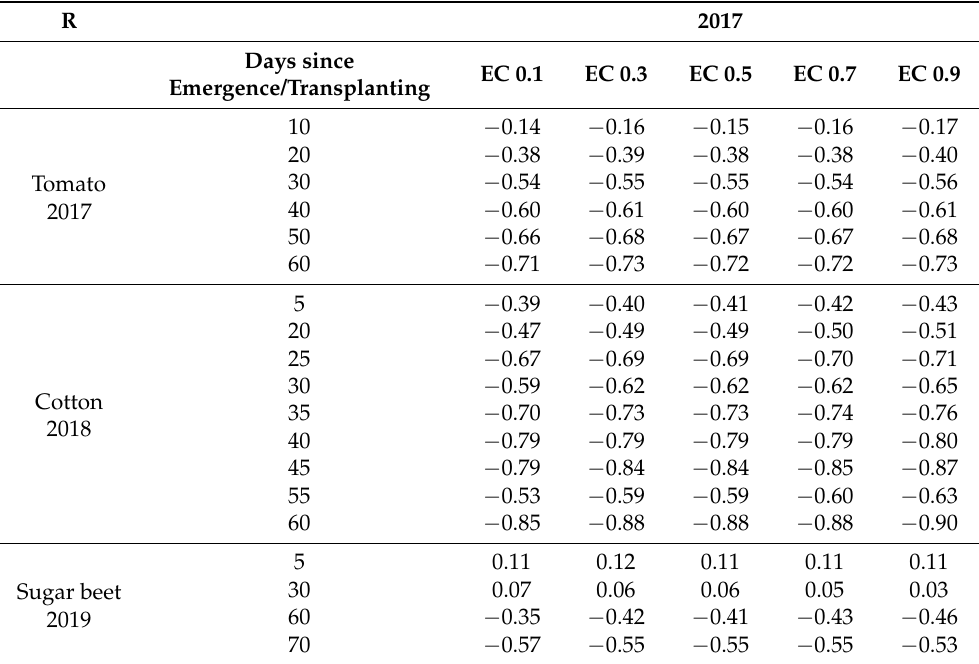
Table 5. Pearson correlation coefficient (R) between NDVI and depth-specific EC, measured along the transect, from emergence/transplanting until reaching the maximum